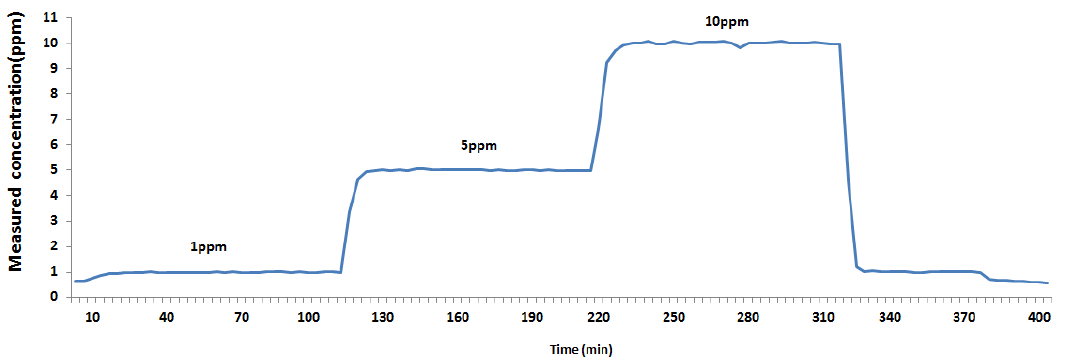
Figure 3. Trend of the concentration changes in